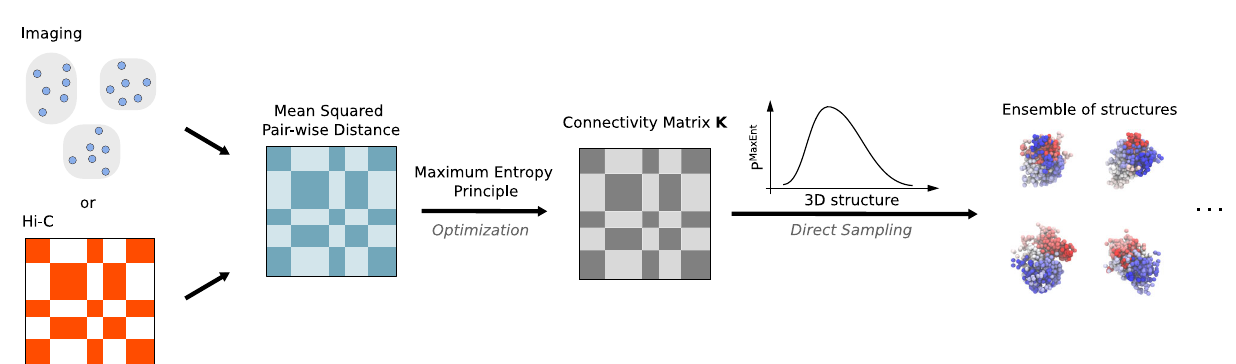
Fig. 1 | Schematic fl owchart for DIMES. Either imaging (measurements of chro- matinlocicoordinates)orHi-Cdata(contactmap)maybeusedtocomputeorinfer the mean pairwise distance matrix, which is used as constraints to determine the maximum-entropy distribution P MaxEnt . The parameters, which we refer to as the